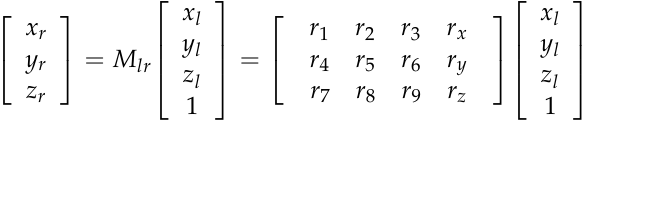
where p l and p r are the image coordinates of the spatial object point in the left and right cameras, respectively, M l and M r are the projection matrices of the left and right cameras, respectively, and X w is the 3D coordinate of the spatial object point in the world coordinate system O l − x l y l z l The relationship between the coordinate system and the O r − x r y r z r coordinate system is represented by the transformation matrix